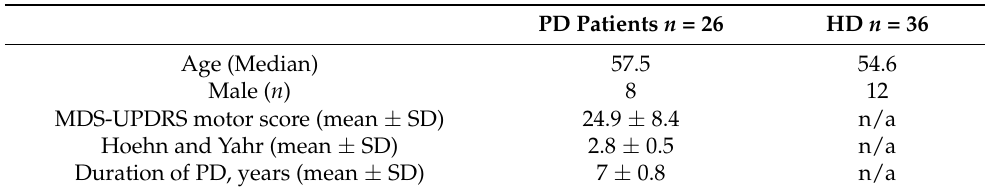
Table 1. PD patients and HD cohort characteristics. N is the number of donors. SD, standard deviation; n/a = not